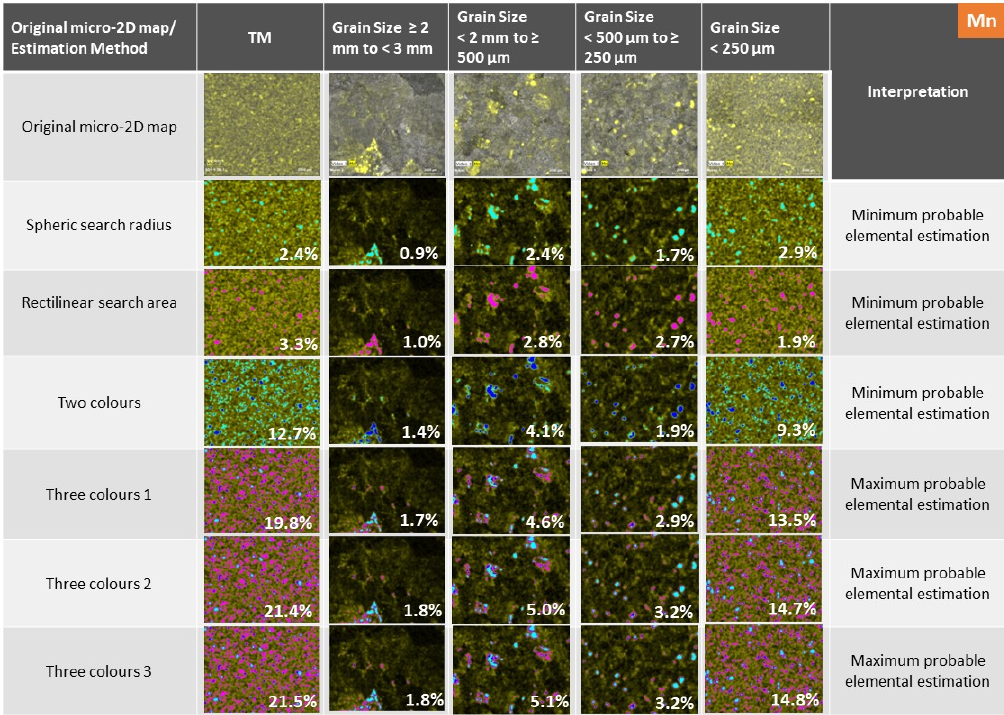
Figure A3. Minimum and maximum probable elemental occurrence in µ-XRF 2D map (percentage of area %) for Cu.